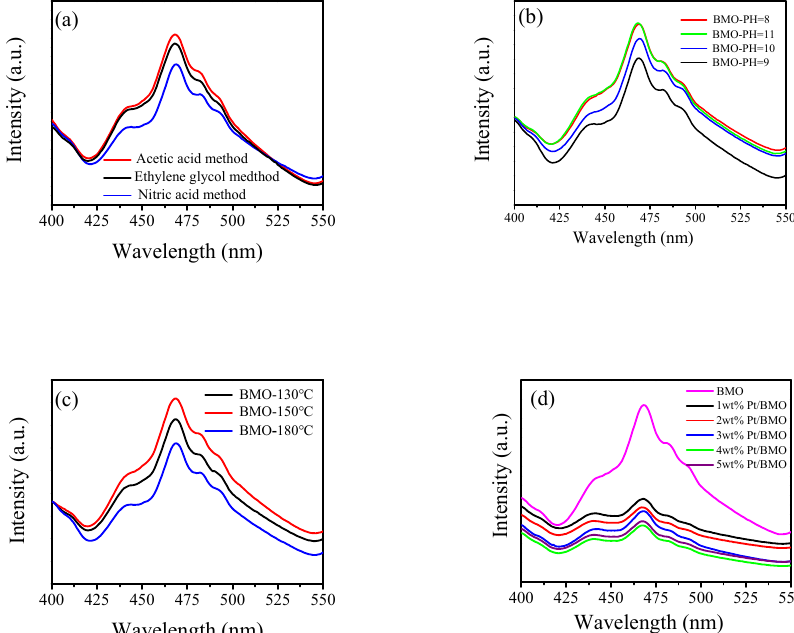
Figure 7. Photoluminescence spectra of γ -Bi 2 MoO 6 with: ( a ) different preparation methods, ( b ) different pH values, and ( c ) different hydrothermal temperatures. Photoluminescence spectra of Pt/ γ - Bi 2 MoO 6 with ( d ) different mass fractions of Pt.